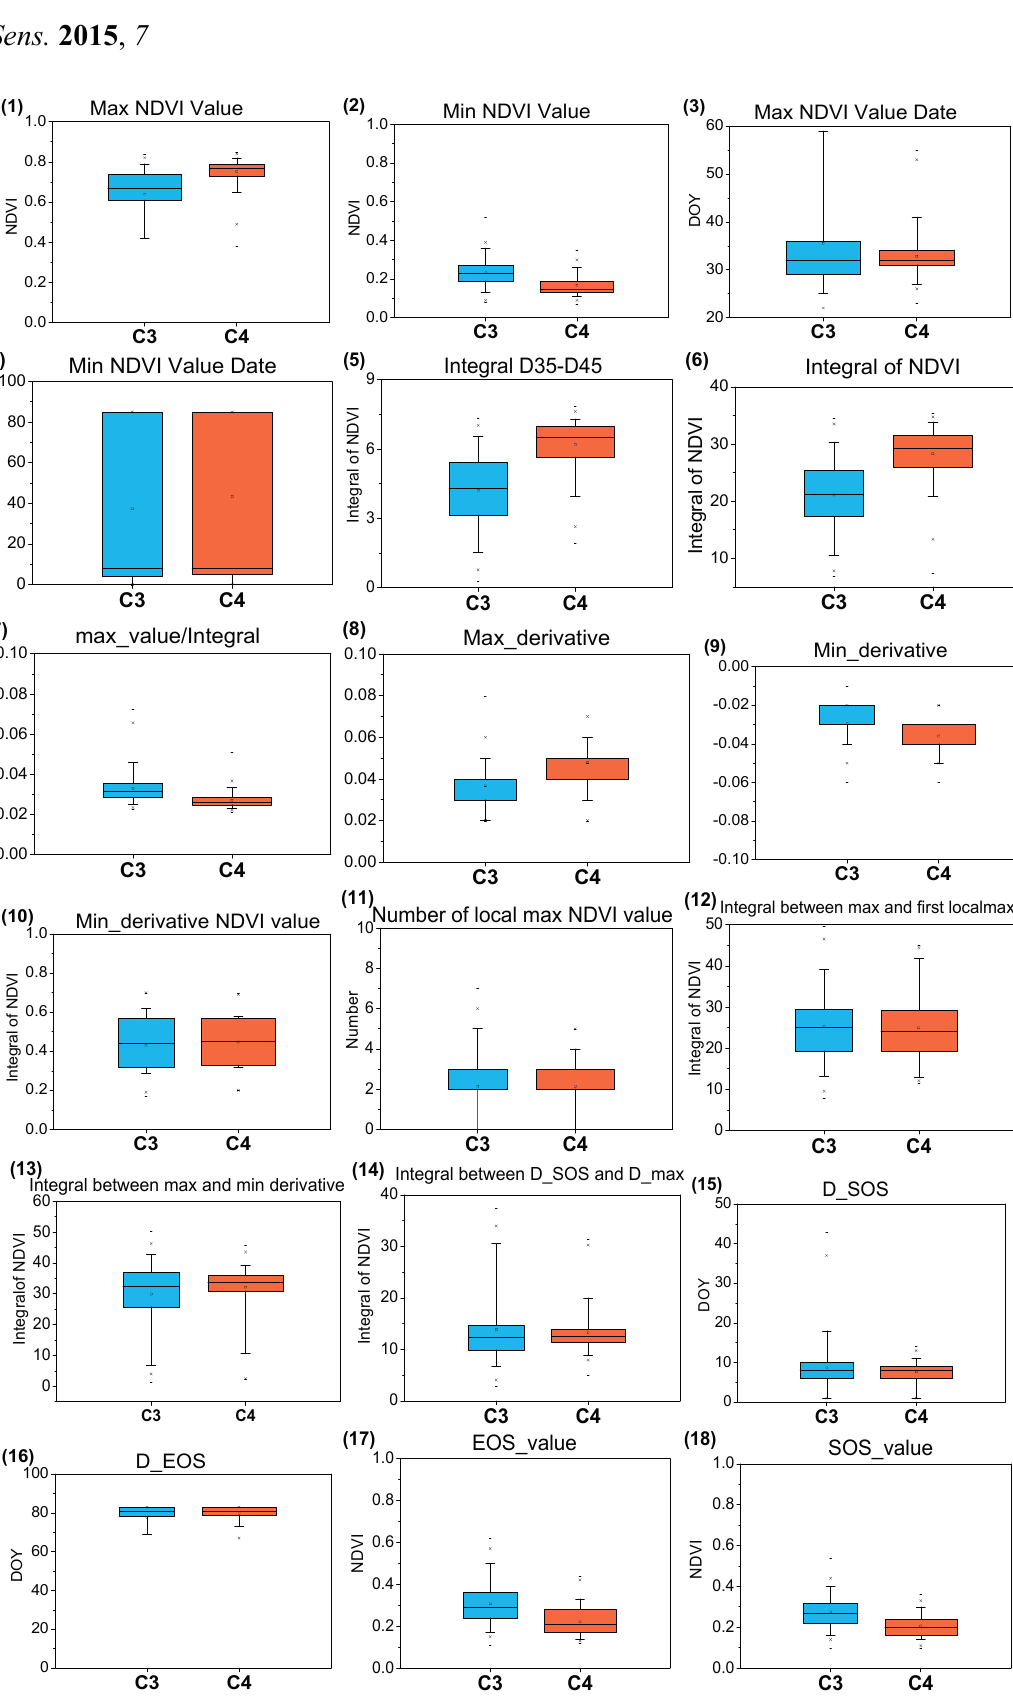
Figure 12. Boxplots of the 18 C3 and C4 classification features. ( 1 – 18 ) are boxplot of every classification feature listed in Table